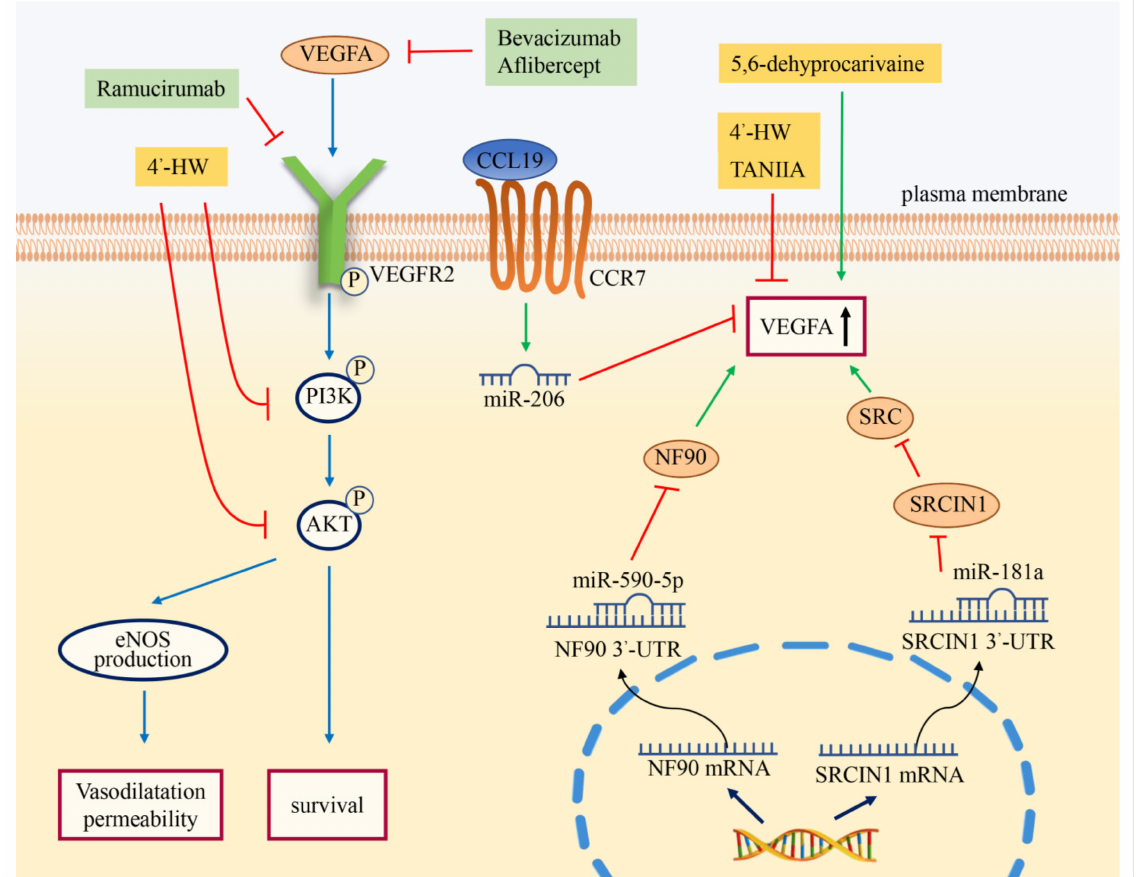
Figure 1. Regulation of angiogenesis via the VEGF signaling pathway in CRC. As monoclonal anti- bodies to VEGFA or VEGFR2, bevacizumab, aflibercept, and ramucirumab can inhibit angiogenesis in CRC by binding to their corresponding molecules. The chemokine CCL19 can promote miR-206 to inhibit VEGFA in a CCR7-dependent manner. MiR-181a and miR-590-5p inhibit the expression of related target molecules by binding to the target 3’-UTR. These processes can affect the expression of VEGFA. 4 (cid:48) -HW can block PI3K and AKT phosphorylation and inhibit VEGFA expression. The compounds Tan IIA and 5,6-dehyprocarivaine can also affect the increase in